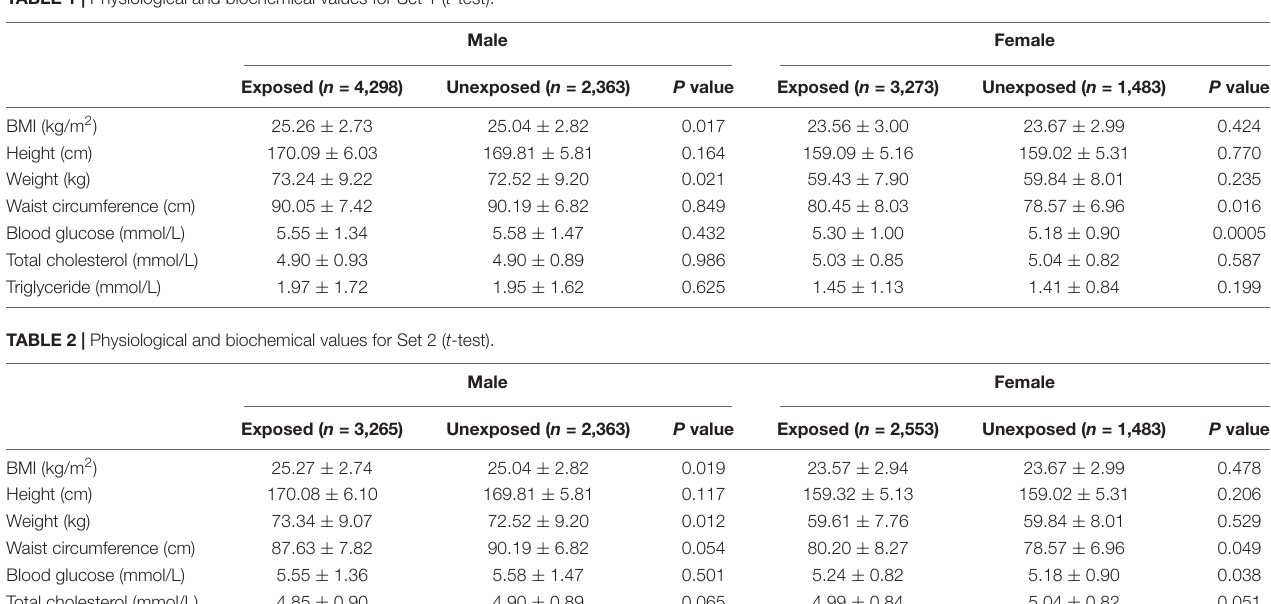
TABLE 1 | Physiological and biochemical values for Set 1 ( t -test).